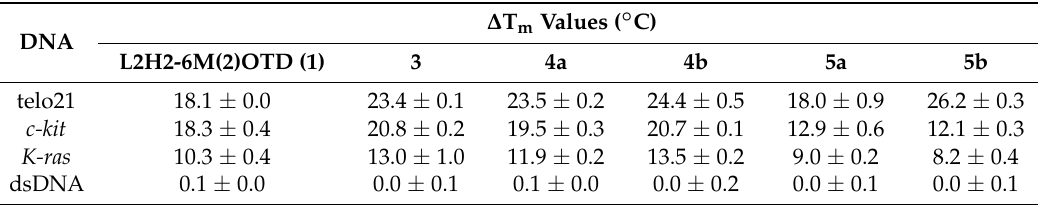
Table 1. Fluorescence resonance energy transfer (FRET) melting analysis of 6OTDs 3 – 5 (1.0 µ M) with G4-forming DNA sequences (0.2 µ M) *.